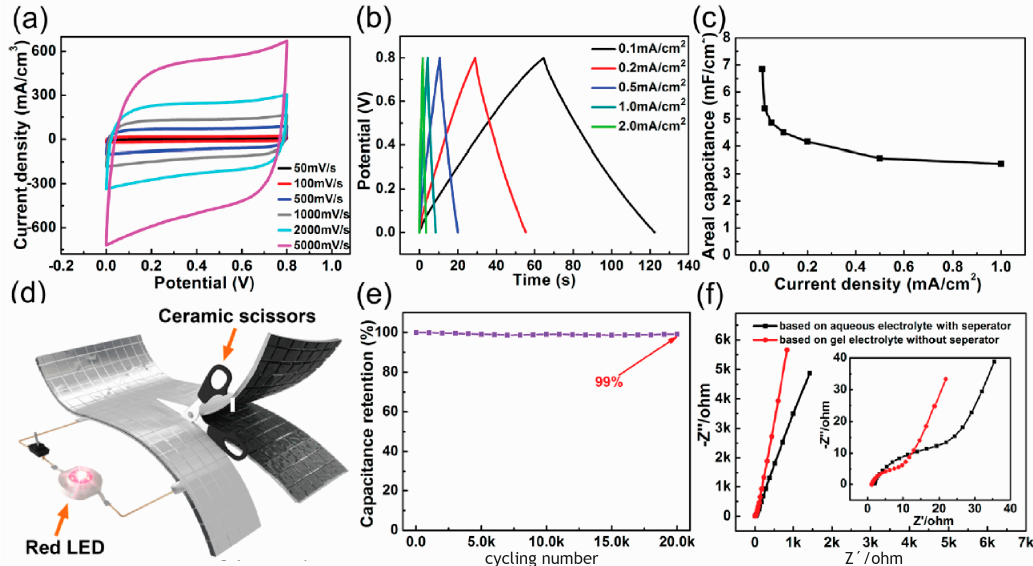
Figure 4. ( a ) CV curves of the TGS under different scan rates. ( b ) GCD curves of the TGS with various current density. ( c ) Schematic illustration of the shape-tailorable supercapacitor. ( d ) Areal and volumetric capacitances of the TGS with different current densities. ( e ) Capacitance retention for the TGS that has undergone 20,000 cycles. ( f ) Nyquist plots of the TGS without separator and the aqueous-electrolyte-based supercapacitor with a separator. The inset in ( f ) is magnification of the high-frequency region (reprinted from reference [72] with permission from the American Chemical Society. Copyright 2015).